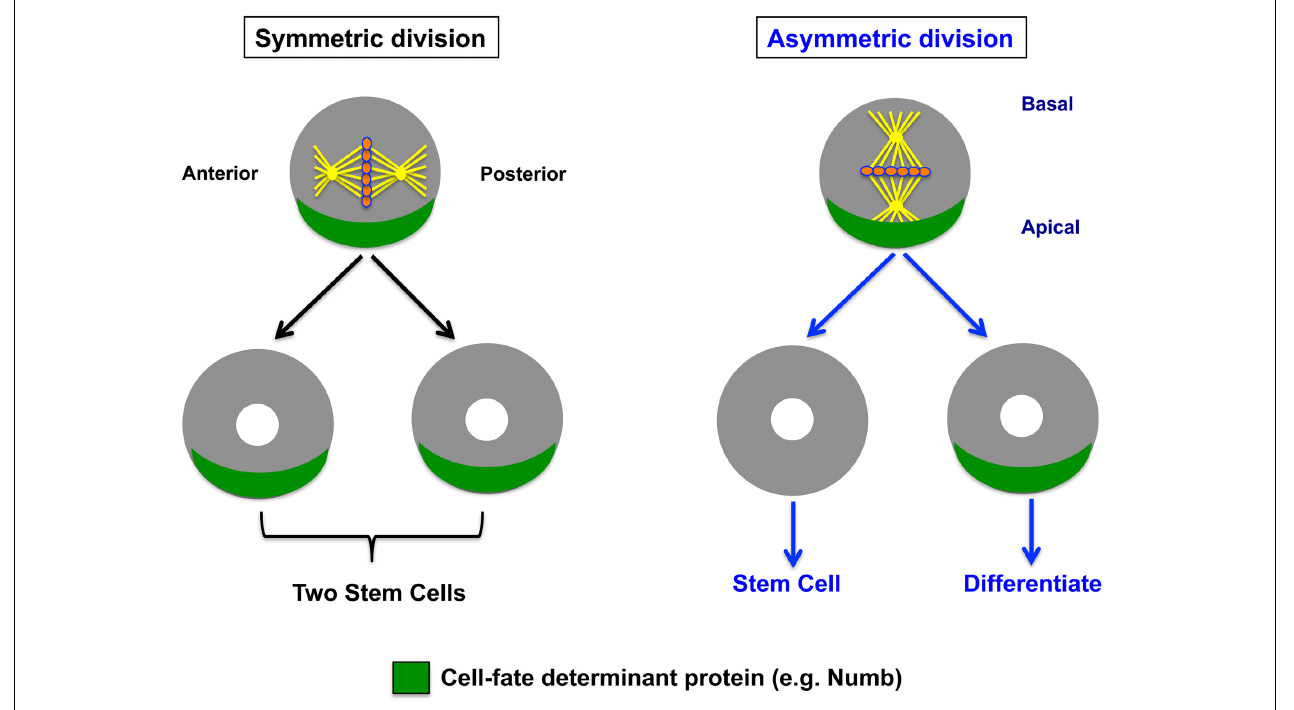
FIGURE 1 | Symmetric vs. asymmetric cell division in epithelial cells. Schematic depiction of a polarized dividing cell show two modes of cell division. During symmetrical division, spindle orientation and determinant protein (e.g., Numb) localization are not coordinated. Determinants segregate equally, giving rise to two equal (stem) cells. During asymmetric division, spindle orientation and determinant protein (e.g., Numb) localization are